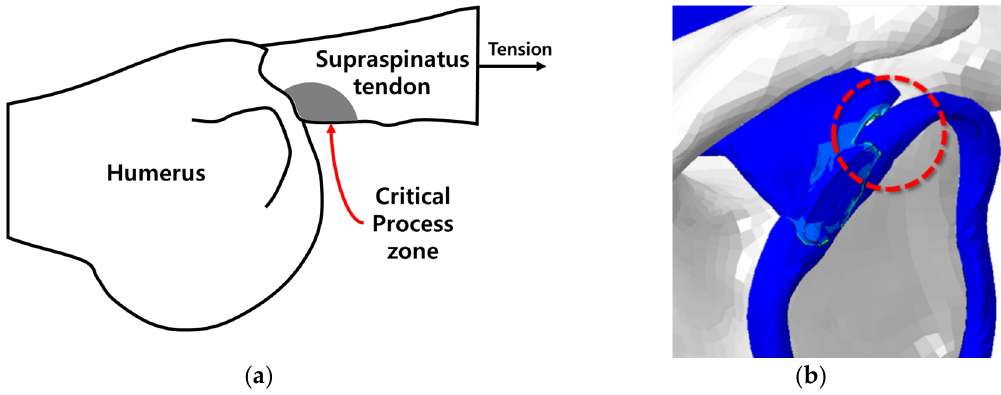
Figure 3. Excessive distortion on the critical process zone: ( a ) the critical process zone of supraspinatus tendon; ( b ) the excessive distortion on the supraspinatus tendon.